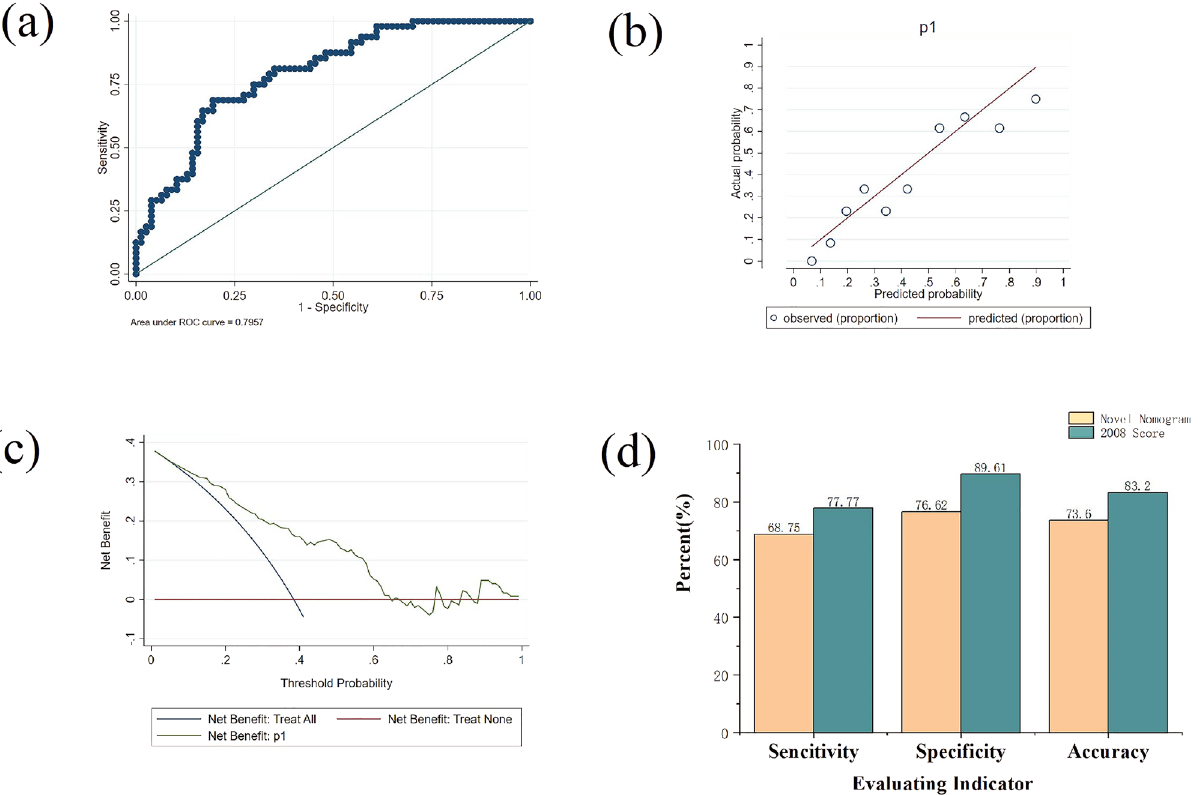
Figure 2. Validation of the nomogram model for AIH in the validation cohort. ( a ) The areas under the curve for the validation cohorts were 0.796. ( b ) The calibration plot suggested that the model had an acceptable accuracy ( p > 0.05). ( c ) The decision curve analysis suggested that the model had great clinical utility if the value of probability was 0.45. ( d ) The sensitivity, specificity, and accuracy of our model compared with the 2008 International Autoimmune Hepatitis Group simplified scoring